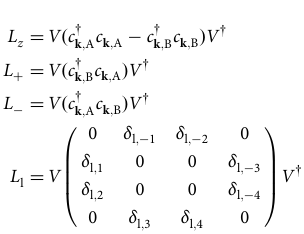
Floquet bands as functions of the fi eld strength E d . They are in good qualitative agreement with each other. Both quantities display tongues with alternating signs and zero-crossings seperating them that agree very well between Δ n ( k ) and ~ σ intra k -axis at m ω ð k Þ . The zero-crossings touch the v F d /2 and y r m Þ , m 2 N . The solid white lines show the the E d -axis at E ð d ; band location of the Floquet band gaps, i.e., where the radial band